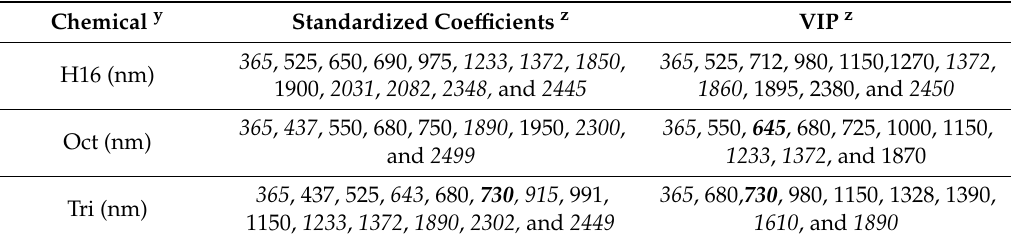
Table 5. Spectral features revealed on living tissue with standardized coe ffi cients and VIP for the wavelengths most important for epicuticular waxes Hentriocontanone-16 (H16), Octacosanol-1 (Oct-1), and Triacontanol-1 (Tri1) based on visible-near-infrared to shortwave infrared reflectance (VSWIR, 350–2500 nm) on leaves using a portable